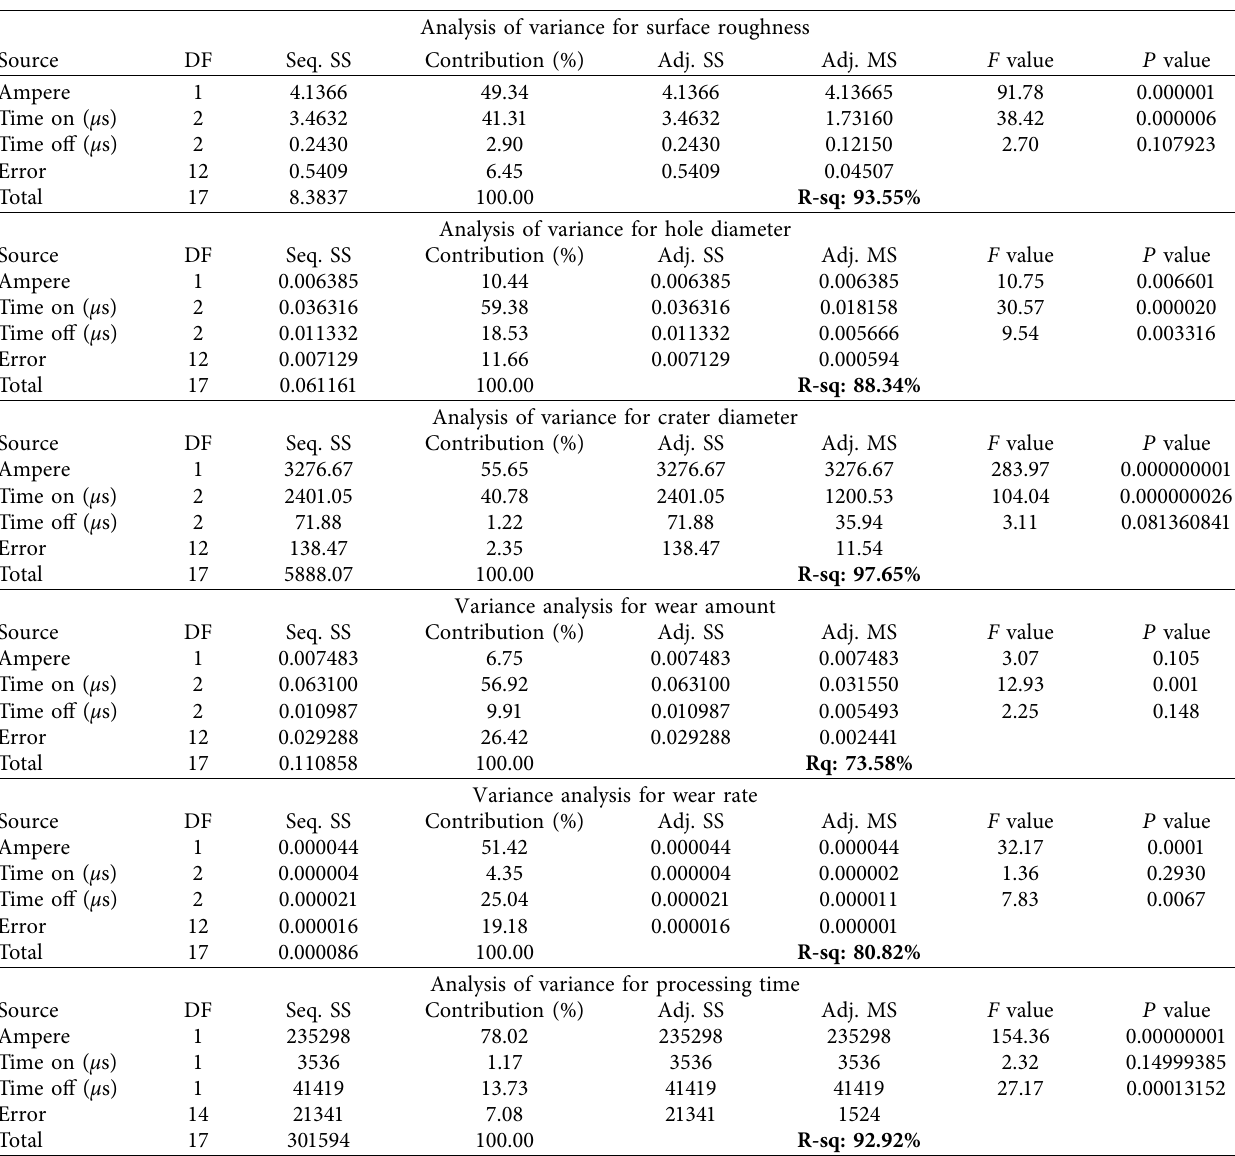
Table 5: ANOVA results. Analysis of variance for surface roughness